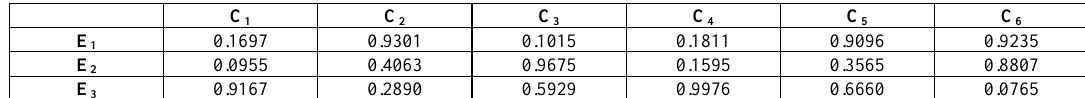
Table 8. The decision matrix for the criteria sets.